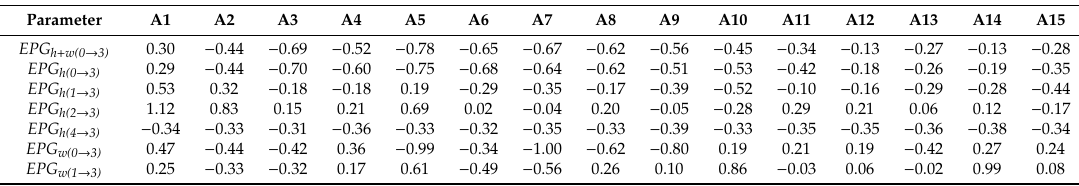
Table 4. Energy performance gap for di ff erent levels of